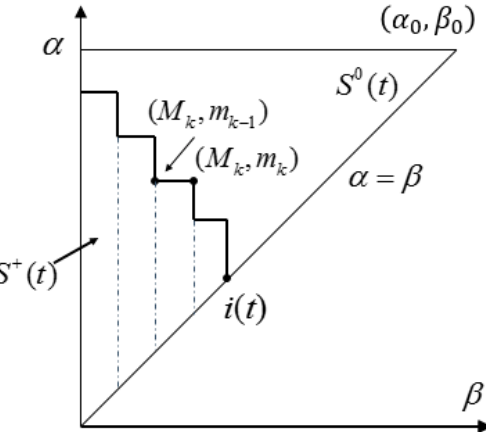
Figure 3. The Preisach Model Triangle for numerical implementation.